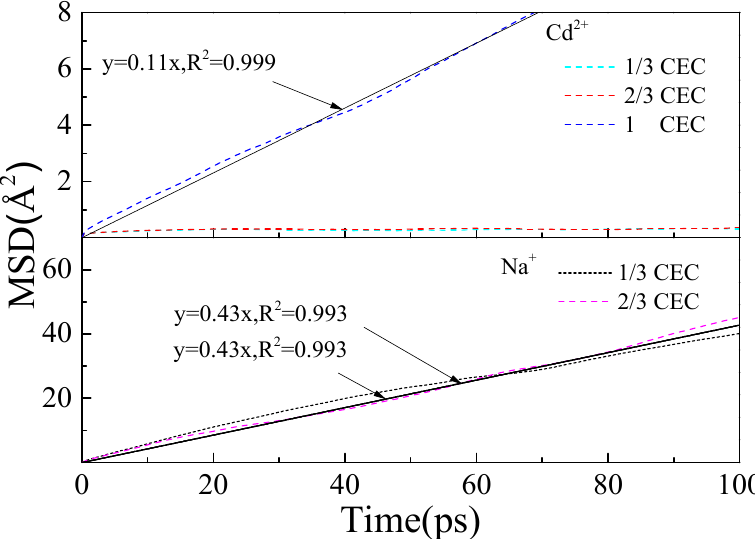
Figure 8. Mean-square displacement of cations at interface.